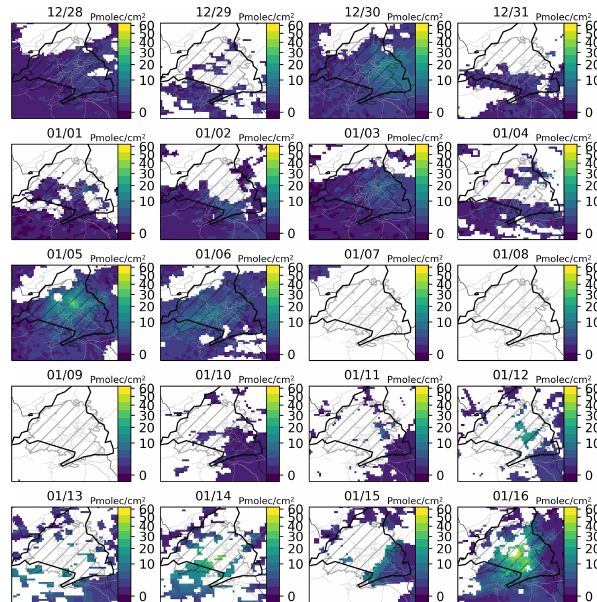
Figure E1. TrC-NO 2 measured by TROPOMI over the Madrid re- gion during the two weeks preceding the 16 January 2021, the day of historical maximum TROPOMI TrC-NO 2 over the Iberian Penin- sula. The Filomena snowstorm occurred mainly between 7–11 Jan- uary 2021 (cloudy). Note that the color scale is not linear. Black lines, grey lines and hatched areas correspond to administrative bor- ders, Spanish major roads and functional urban areas, respectively (sources: see Sect.